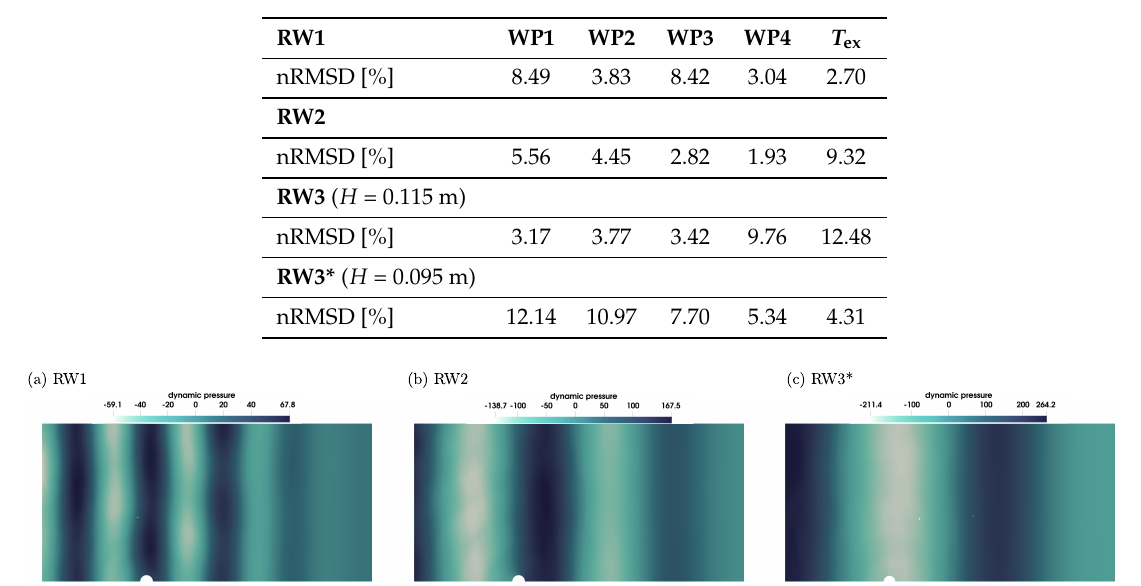
Figure 13. Screen shot of the dynamic pressure for waves RW1 ( a ), RW2 ( b ), and RW3* ( c